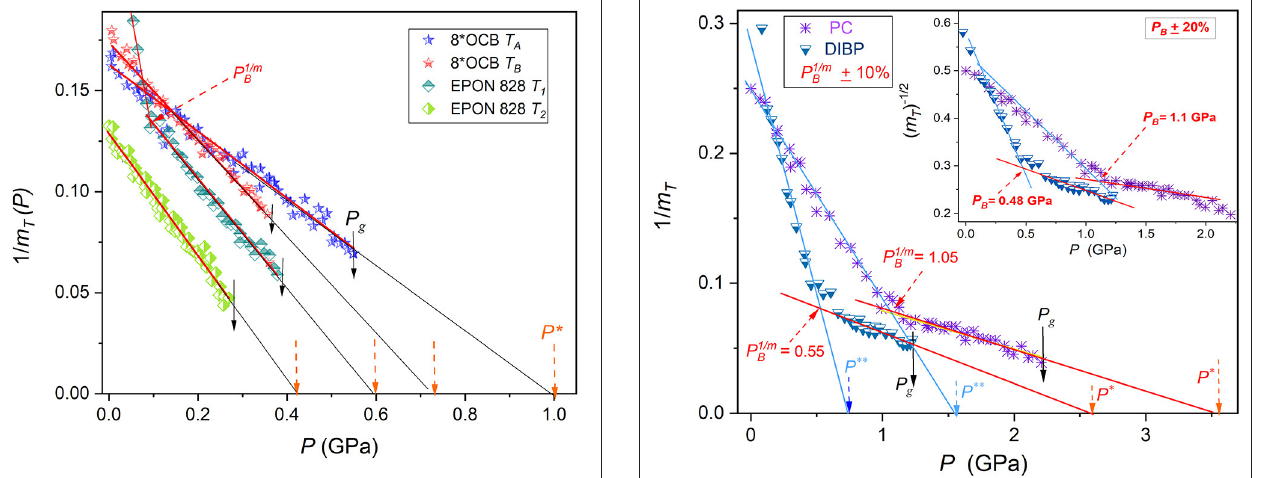
FIGURE 3 | The universal previtreous behavior of the reciprocal of the pressure apparent fragility (Equation 11) for supercooled 8 * OCB and EPON 828, basing on experimental data from Figures 1 , 2 . Results of the linear regression fit (Equations 12, 13) in Table 1 are collected. Solid arrows indicate the glass transition. The dashed (orange) arrows show singular pressures P ∗ g , P ∗ B . For the “high temperature” isotherm for EPON 828, the dynamic crossover pressure P ′ B is also indicated.